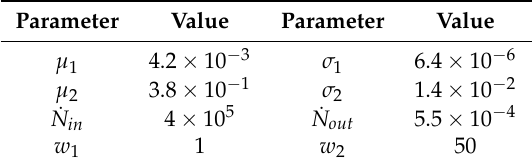
Table 3. Model parameters used for